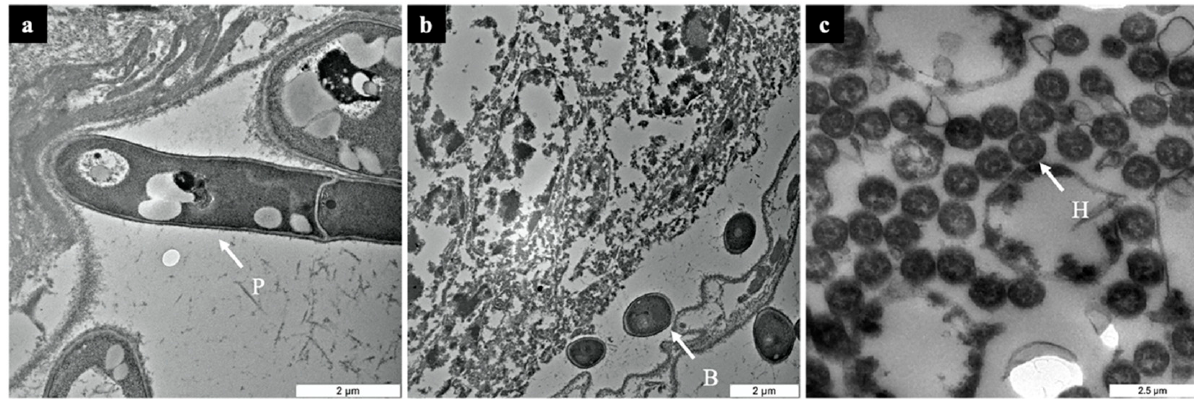
Figure 2. Cross-section images of Coptotermes curvignathus after inoculation with Metarhizium anisopliae as visualized under TEM. ( a ) 48 h post-inoculation (PI) = a hypha penetrating into the host by pressing on the termite’s epidermal cell, ( b ) 96 h PI = dissemination of blastospores within the hemocoel, and ( c ) 144 h PI = hyphal bodies colonizing the intercellular part of the termite. P = penetrant hypha, B = blastospore, H = hyphal body. Table 1. MALDI-TOF mass fingerprinting data of the 13 differentially expressed proteins isolated from Metarhizium anisopliae -infected Coptotermes curvignathus . Proteome changes in the infected termite were compared in a time-lined post-inoculation (PI) experiment to control proteins, extracted from 2D electrophoresis gels prior to identi- fication.